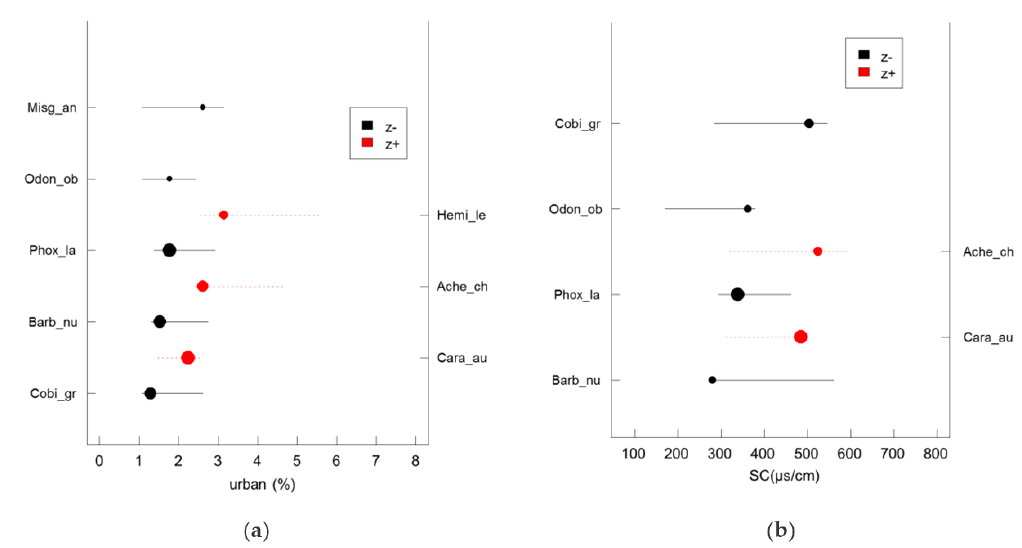
Figure 3. The responses and thresholds of fish taxonomic structure to urban land use ( a ) in SC ( b ) in TITAN. Red circles (positive response) represent fish species that become more frequent or abundant along the gradient, while the black circles (negative response) indicate fish species that decline in frequency or abundance. Horizontal lines overlapping each circle indicate the 5th and 95th percentiles of 500 bootstrapped runs. Circles are sized in proportion to the magnitude of the response (z-scores). Table 5. The assemblage-level thresholds of fish taxonomic structure to stressors in the Taizi River.